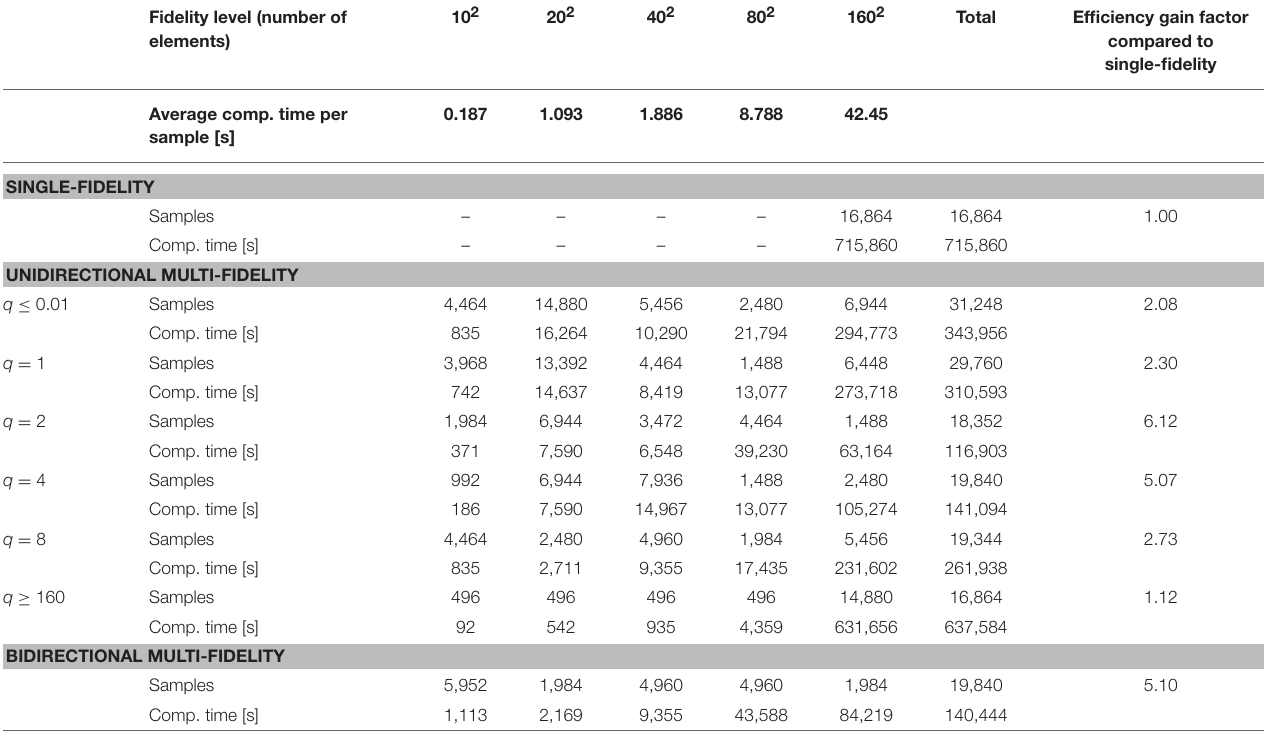
TABLE 4 | Computation times and sample numbers for different training strategies for the membrane problem from section “Two-dimensional problem: elastic deformation of a thin membrane under loading.” Fidelity level (number of